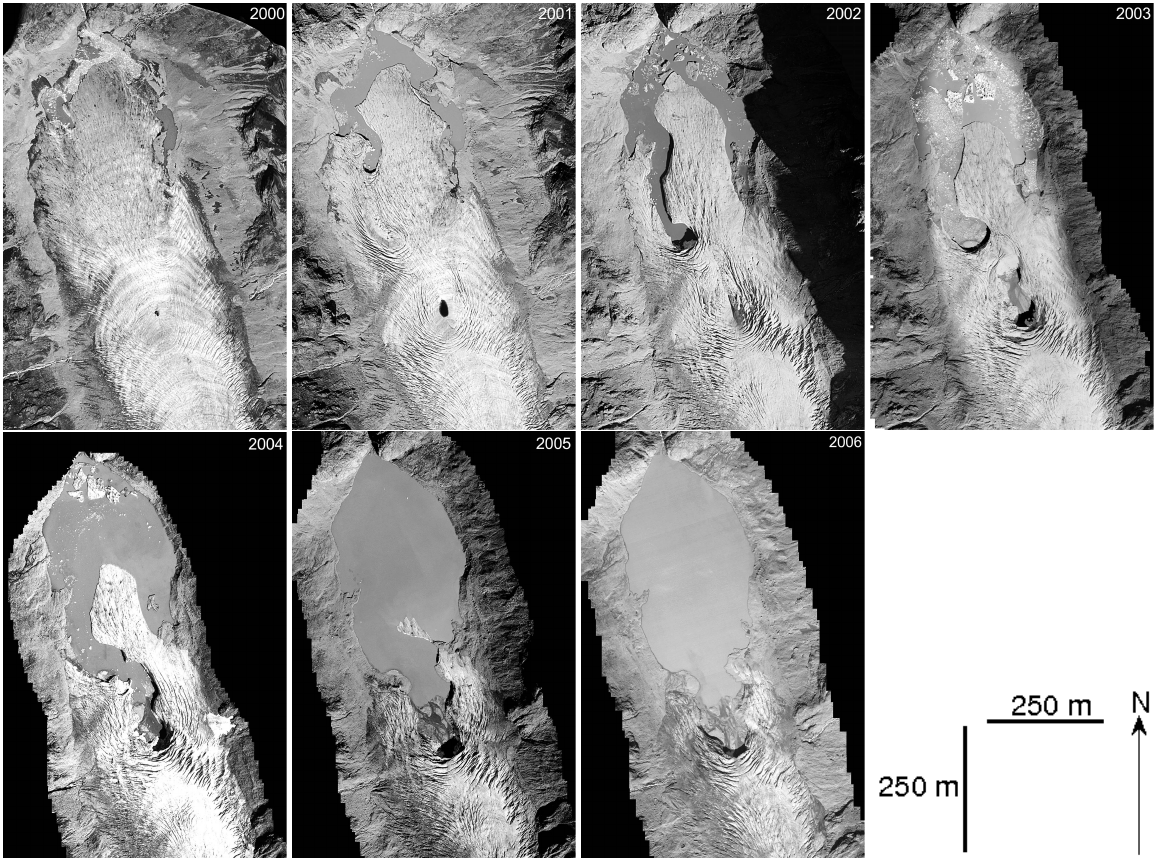
Fig. 5. Orthophotos of the glacier terminus from 2000 to